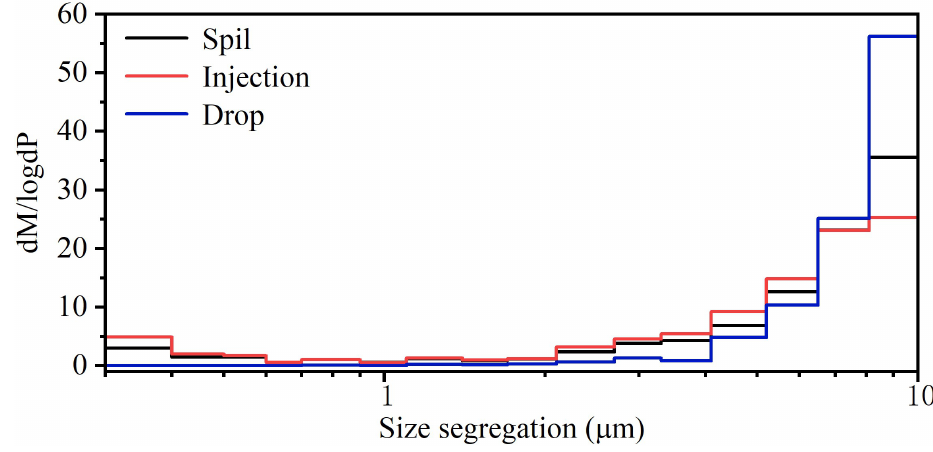
Figure 7. Mass concentration